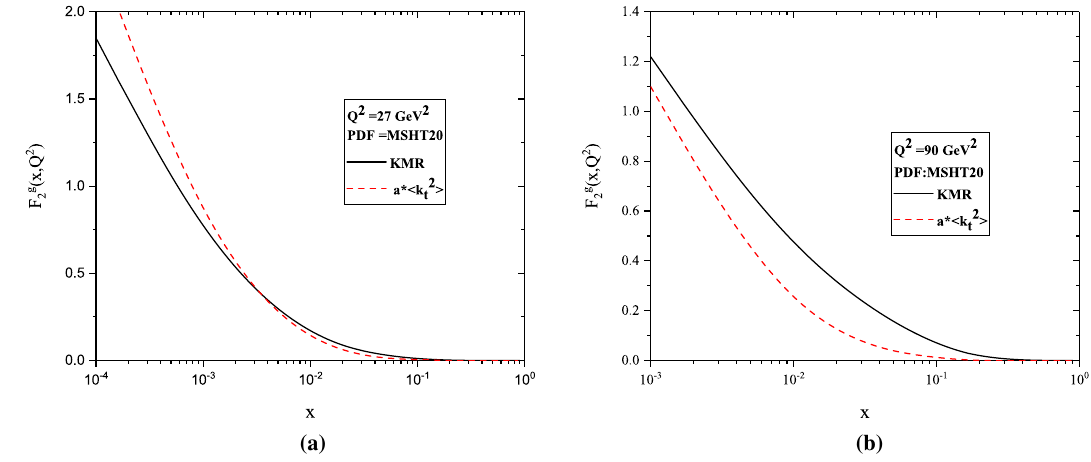
Fig. 11 The comparison of gluon contribution to the structure function of proton, using KMR-UPDFs and Gaussian dependent transverse momen- tum (discussed in the Sect. 3.2) multiply by the corresponding PDFs set in the hard scale a Q 2 = 27 GeV 2 and b Q 2 = 90 GeV 2 with a = 39 .